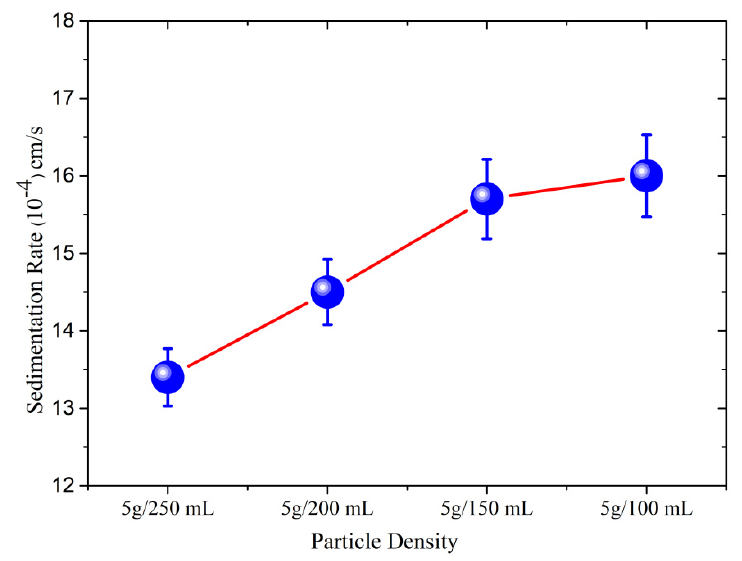
Figure 7. Effect of particle density on sedimentation rate of BaFe 11.2 Mg 0.4 Al 0.4 O 19 .